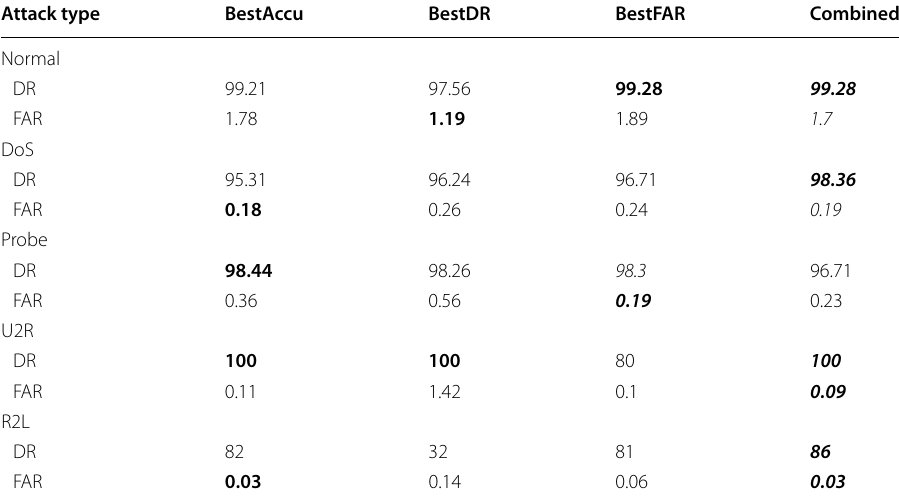
Table 7 Performance of combined solutions Attack type